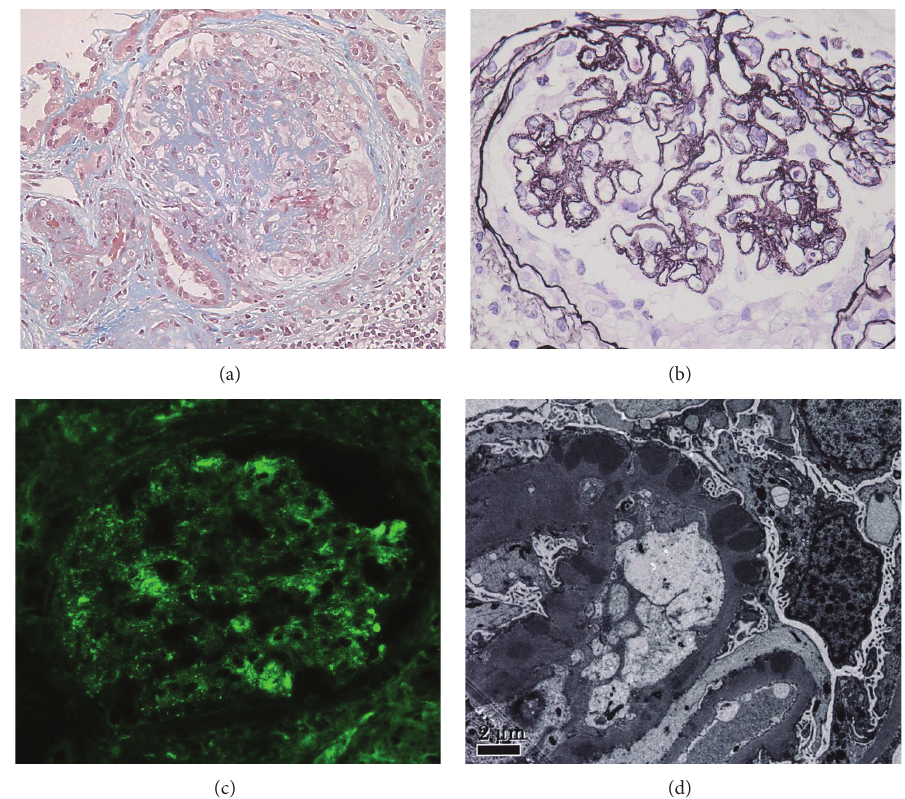
Figure 2: (a) Fibrocellular crescent in Bowman’s space with significant collapse of glomerular tufts and the presence of glomerular-fibrinoid necrosis (Masson-trichrome stain). (b) GBM thickening including spike and bubbling formations in the subepithelial lesions (PAM stain). (c) Granular staining for IgG along glomerular capillary walls (IgG immunofluorescence stain). (d) Electron-dense deposits in the subepithelial lesions (electron